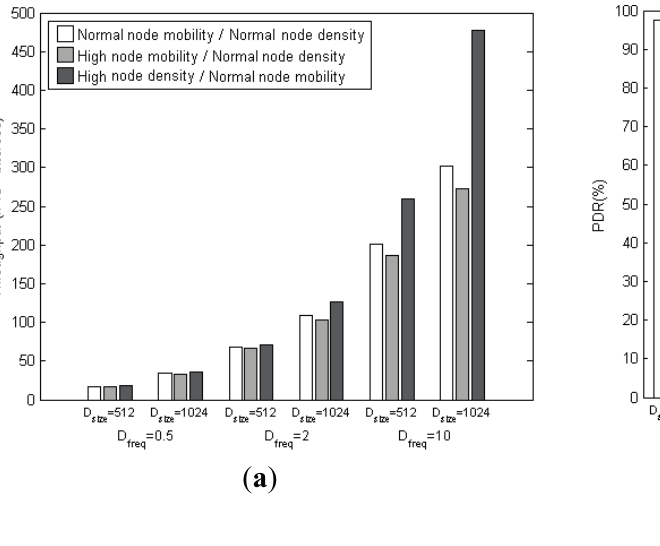
Figure 20. ( a ) Throughput; ( b ) PDR; ( c ) End-to-end delay; and ( d ) Energy cost performances under node density and mobility parameter